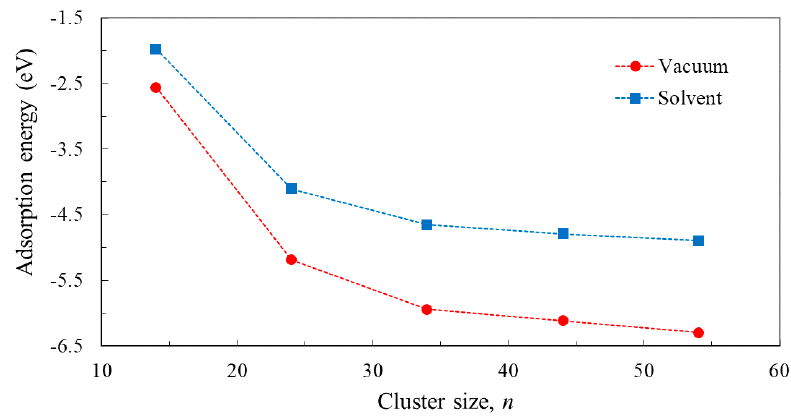
Figure 17. Adsorption energy of PV on the Ti n O 2 n +2 H 4 clusters ( n = 14, 24, 34, 44, 54), calculated by DFT at the B3LYP/3-21G(d) level in vacuum and in water solvent.